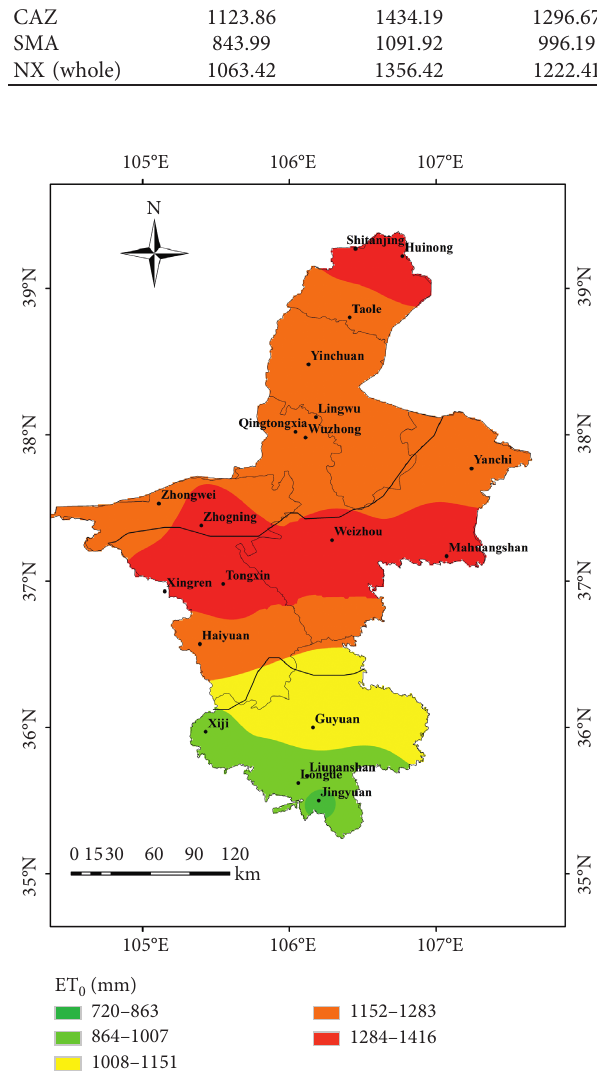
Figure 11: Spatial distribution of annual average ET